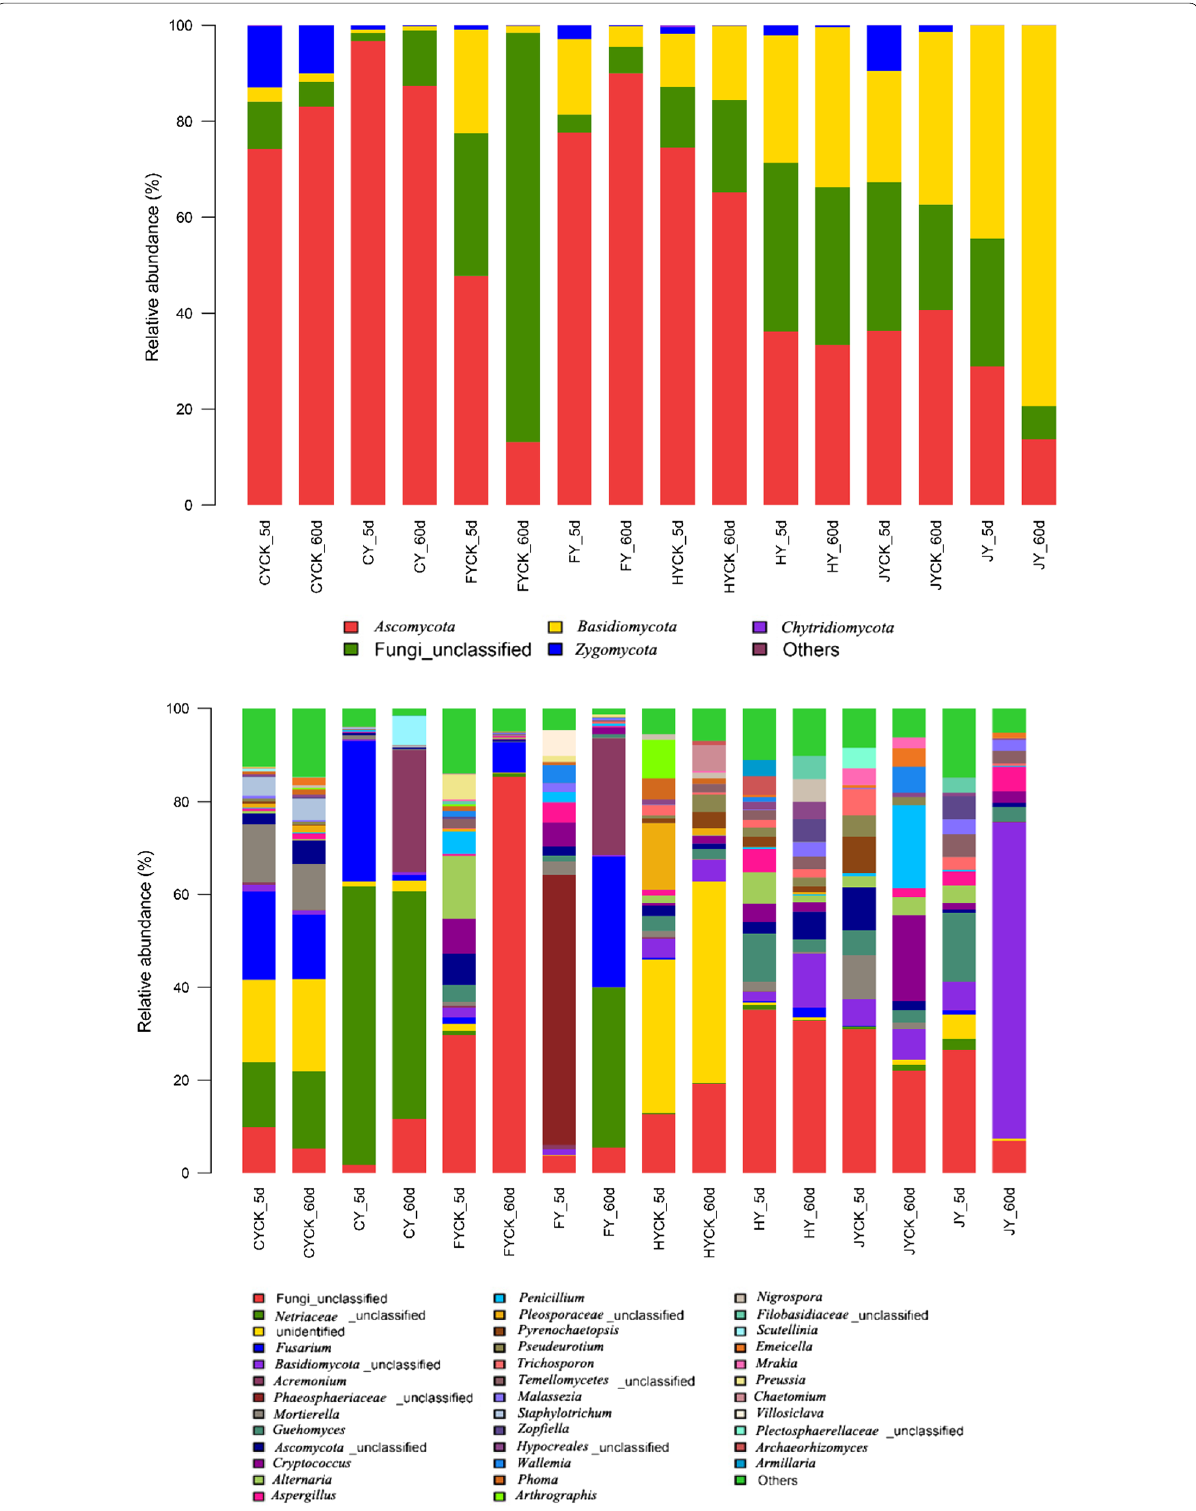
Fig. 3 Eukaryal composition of the different communities ( a Percentage of relative read abundance of eukaryal phyla within each community; b Percentage of relative read abundance of eukaryal genus within each